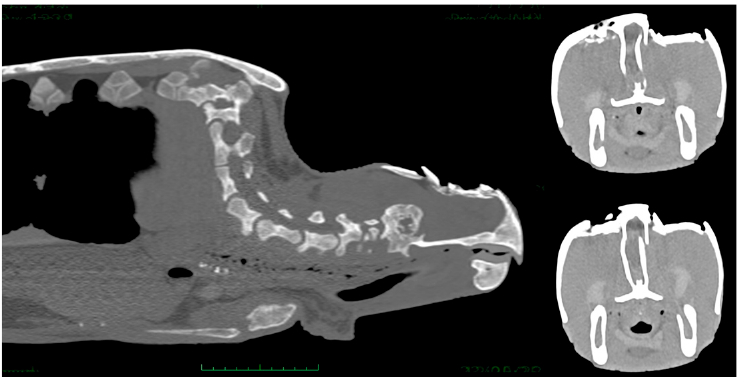
Figure 7. CT scan images showing comminuted fractures of the parietal, postorbital, prefrontal, and frontal bones. The lesions were lytic and skull fragments appeared inverted toward the disrupted dura, pneumocephalus and cerebral lacerations and cerebral swelling are evident. In six cases, the ocular globe was shifted downward due to the pressure of the sur- rounding tissue resulting in brain contusion and compression of the salt gland. In moderate and mild cases, parietal and postorbital fragments were deeply or superficially depressed, respectively (Figure 8).